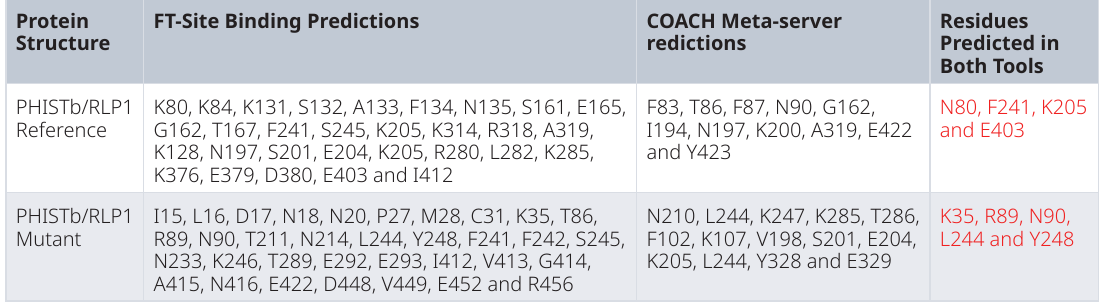
Table 5. Amino-acids found within binding sites clusters in both reference and mutant PHISTb/RLP1 protein structures as predicted by FT-Site and COACH softwares. The highlighted residues are predicted by both softwares. This puts emphasis on the accuracy of the